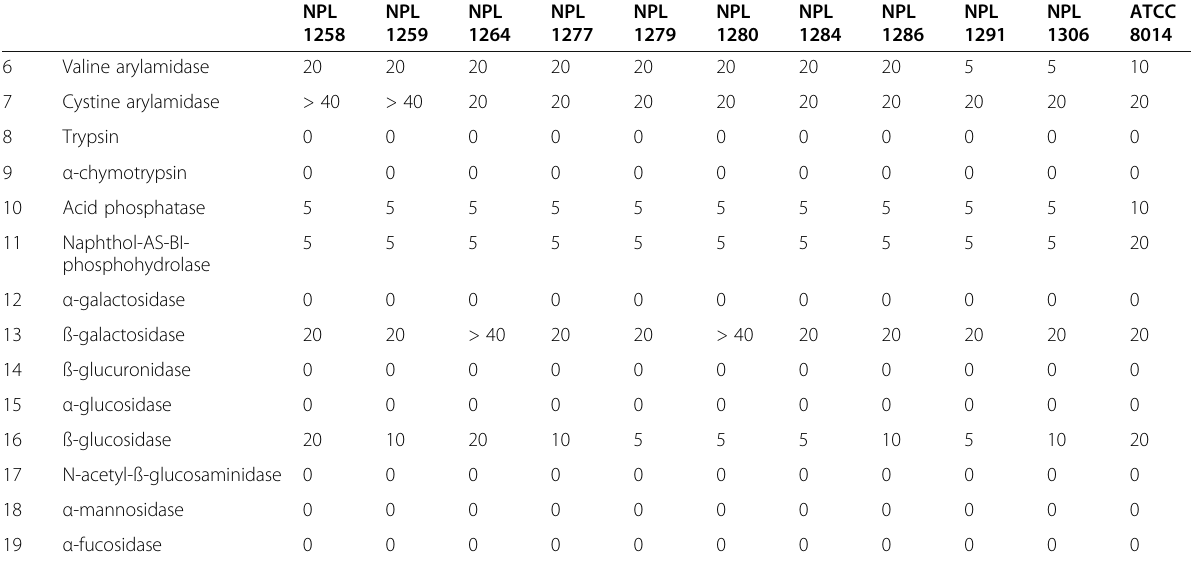
Table 6 Enzyme characterization and carbohydrate utilization of selected LAB (Continued)